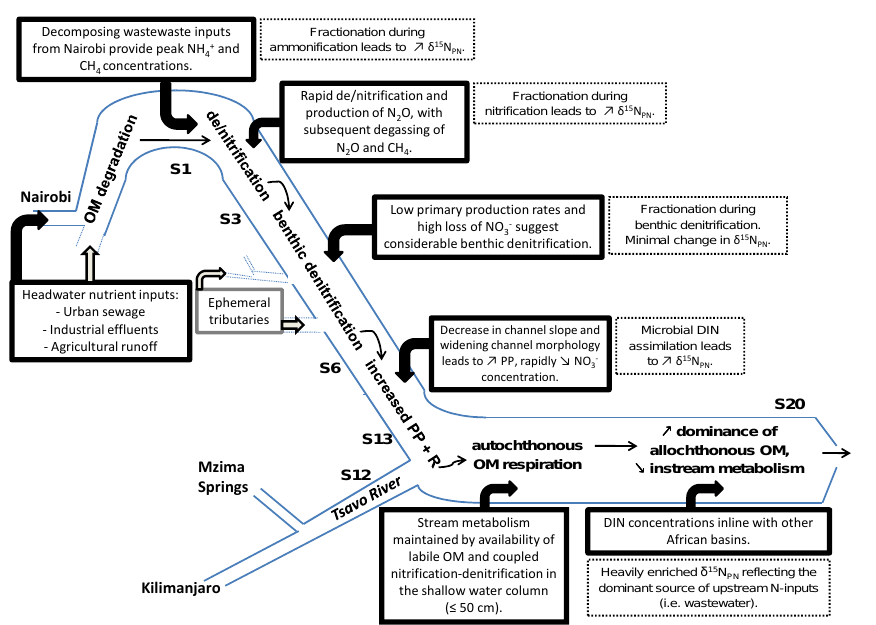
Fig. 12. Conceptual scheme of dry season N cycling in the A-G-S River catchment, Kenya. (Upper left) Surface runoff and direct input of organic wastes in the upper catchment provide large quantities of DIN at S1, much of which has been transformed and removed from the aquatic system below S13. Dominant processes and river characteristics along each reach (bold boxes with arrow) are outlined, as well as downstream evolution of the δ 15 N PN signature (dashed